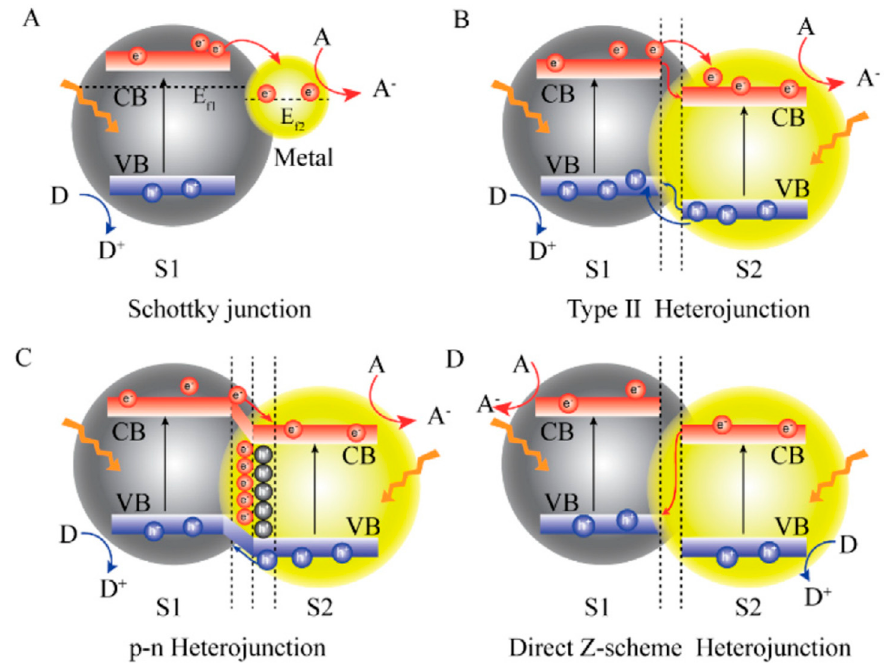
Figure 13. Separation mechanisms of charge carriers in hybrid materials: ( a ) Schottky junction; ( b ) Type II Heterojunction; ( c ) p-n Heterojunction; and, ( d ) Direct Z-scheme Heterojunction [112].